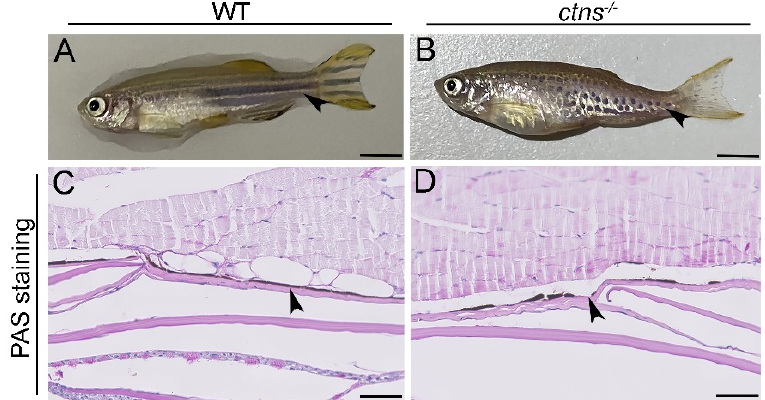
Figure 6. Hypopigmented spotted skin pattern in ctns − / − zebrafish. ( A , B ) Representative pictures of wild-type ( A ) and ctns − / − ( B ) 18-month-old zebrafish. The scale bars represent 0.5cm. The black arrowheads indicate the different striped skin patterns. ( C , D ) PAS-stained pictures of epidermis of wild-type ( C ) and ctns − / − ( D ) 18-month-old zebrafish. The black arrowheads highlight the melanin layer. The interruption in the melanin layer is present in ctns − / − ( D ) while it is absent in wild-type zebrafish ( C ). The scale bars represent 50 µm.